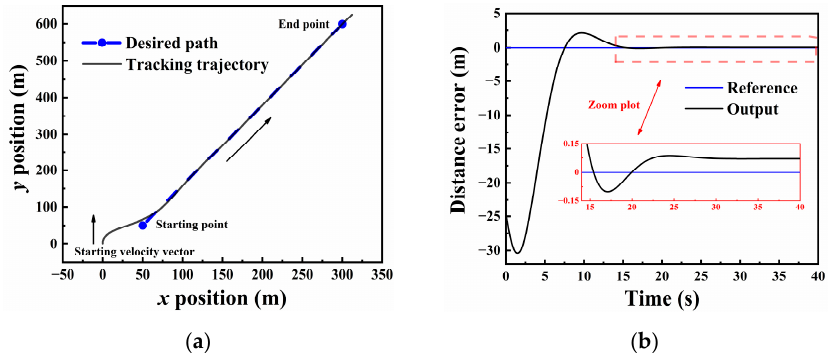
Figure 25. Results of following a straight-line path: ( a ) flight trajectory; ( b ) distance error. Following an orbit path is more difficult than a straight-line path. The vector field of the circular path is similar to that of the straight-line path and is not shown here. The expected course angle can be expressed by Equation (22) when following an orbit path.